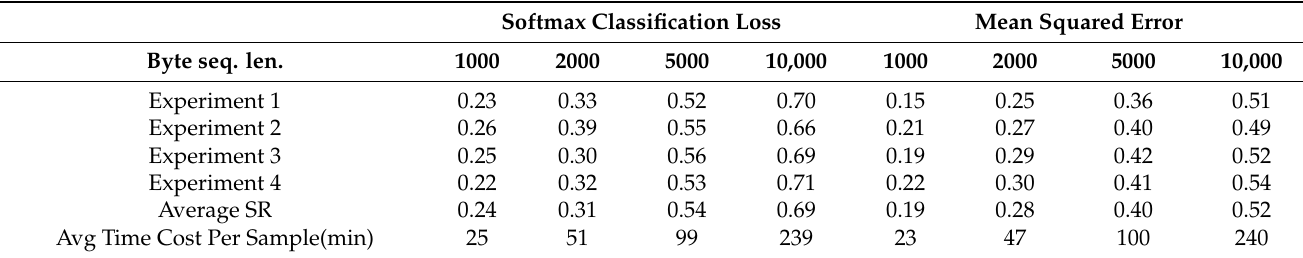
Table 6. SR of the gradient-based method